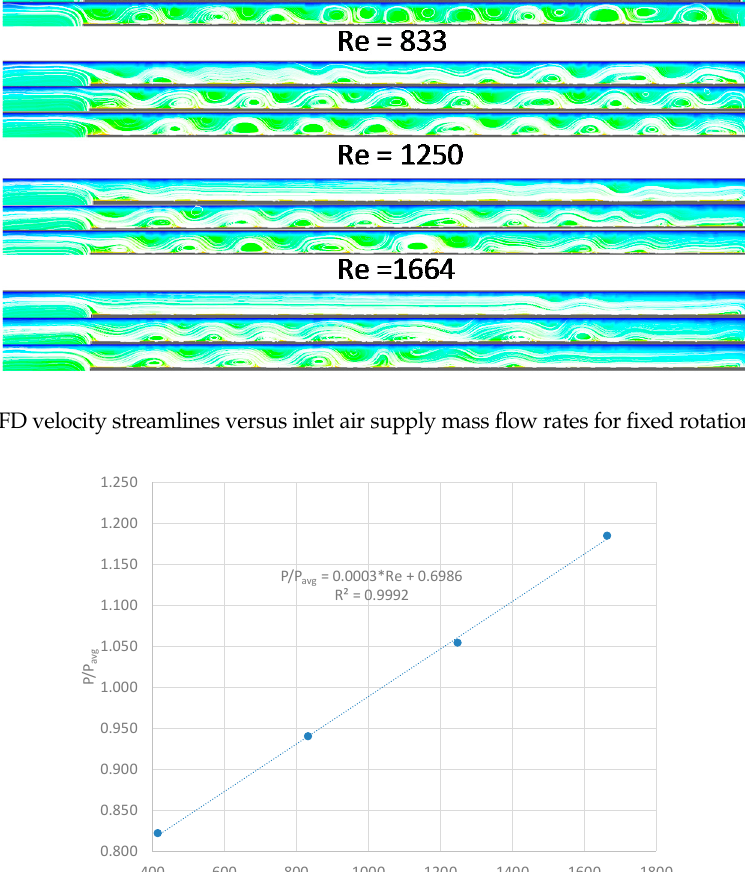
Figure 21. Isotherms for rotor parasitic heat flux q ” = 3541 W/m 2 . Figure 22 shows the isotherms for a parasitic heat flux of q ” = 7029 W/m 2 imposed, or in other words 200 W parasitic applied to the outer surface of the motor rotor.